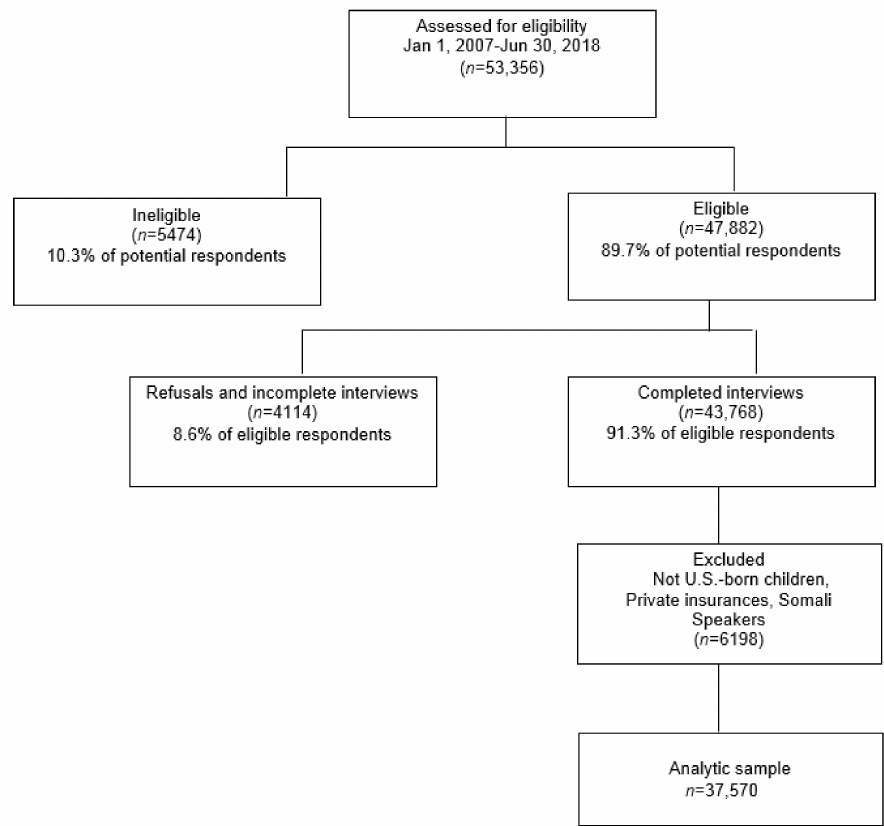
Figure 1. Description of analytic